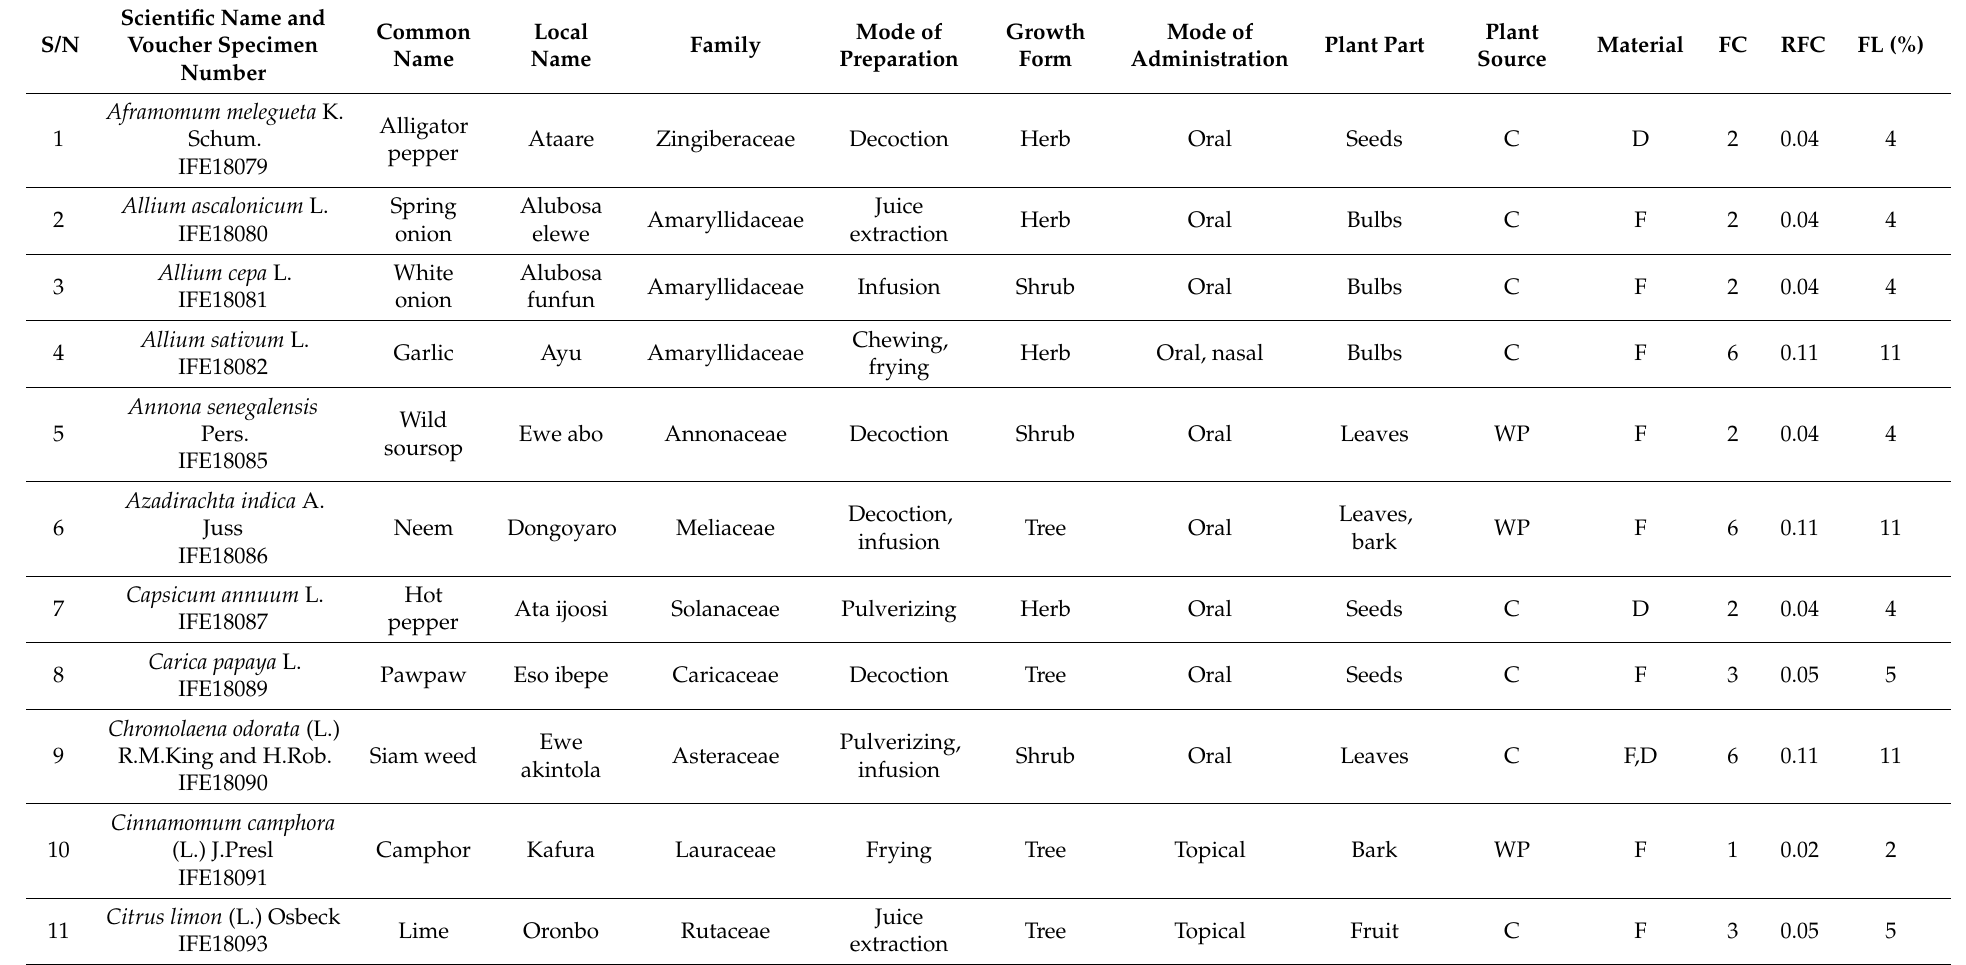
Table 4. Medicinal plants used to treat and prevent flu in Ogbomosho North and South Local Government Areas, Oyo State,